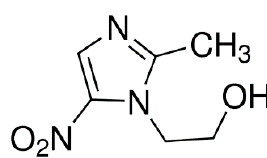
Figure 1. 2-Methyl-5-nitroimidazole-1-ethanol (metronidazole, MTZ).